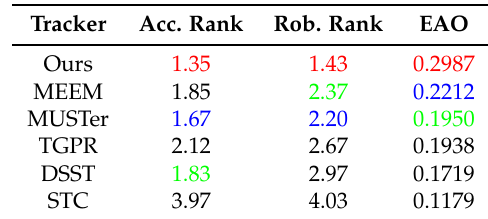
Table 3. Average ranks of accuracy, robustness, and expected average overlap under baseline experiments on the VOT-2015 dataset. The best three scores are highlighted in red, blue, and green, respectively.